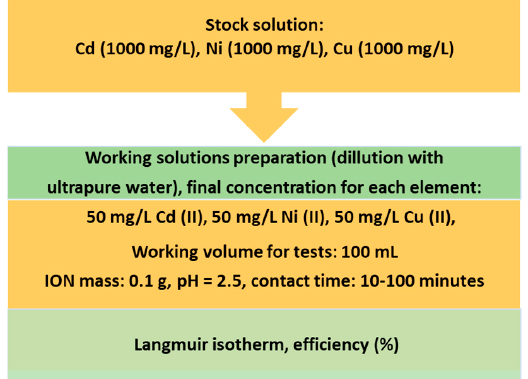
Figure 3. Schematic procedure for the preparation of the ternary heavy metals (Cd, Ni, Cu) aqueous system.